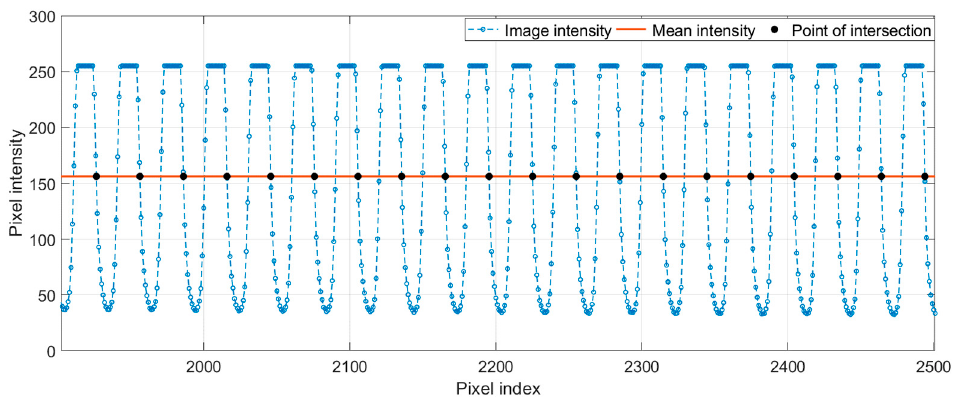
Figure 9. Points of intersection between the mean intensity of the whole 1D image and the 1D image intensity curve.